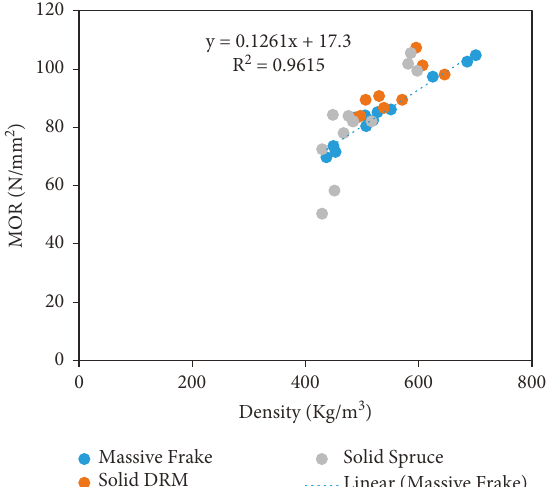
Figure 12: Bending strength as a function of density for massive Terminalia Superba (Frak´e), Spruce , and Dark red meranti ( Shorea spp .) specimen.